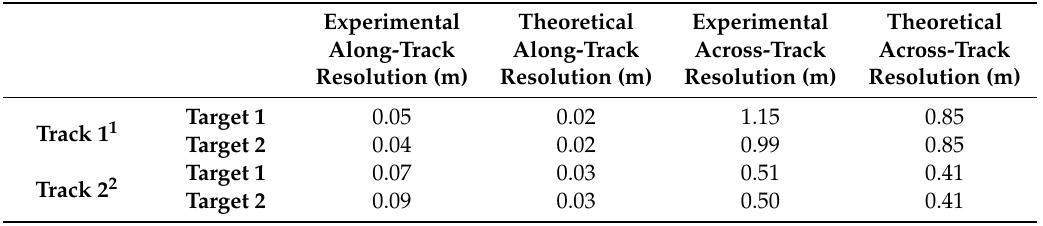
Table 4. Along- and across-track resolution